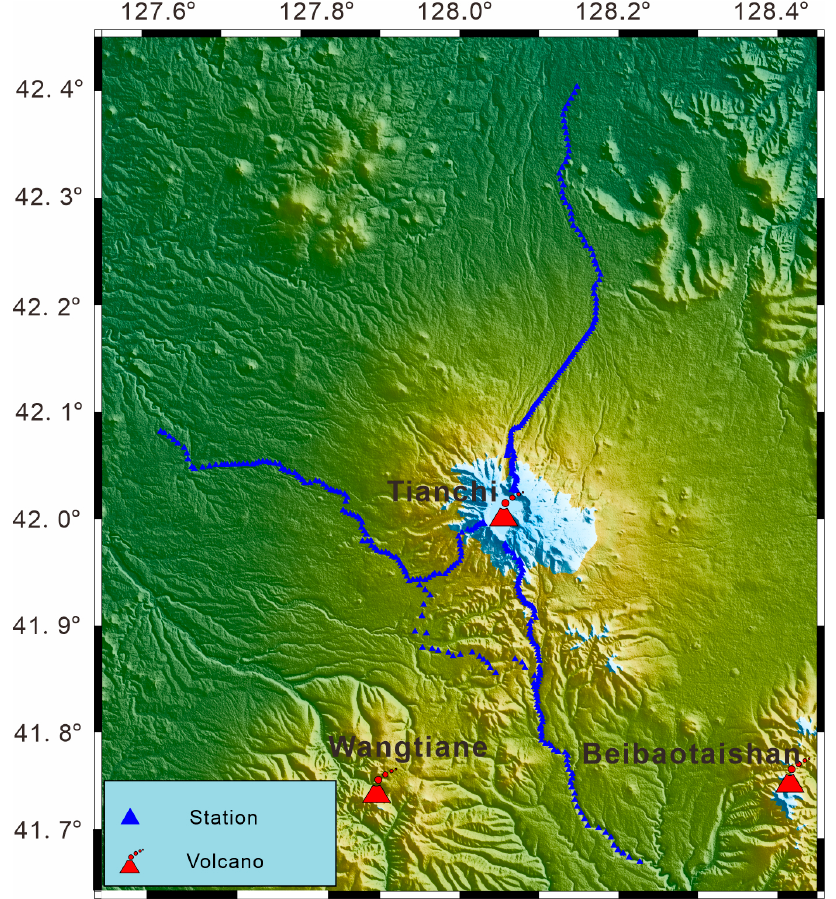
Figure 1. The study region. The blue triangles represent the locations of seismometers. The red symbols indicate the three main craters in the